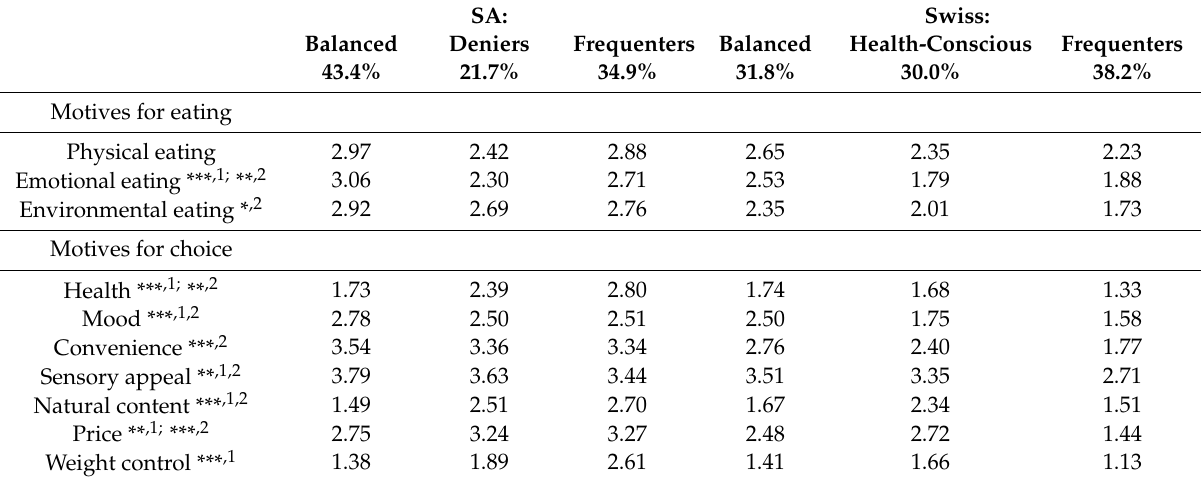
Table 4. Mean scores on the clustering scales and contrast analysis results by clusters of consumers’ motives for eating and choosing SBPs. SA: Swiss: Balanced Deniers Frequenters Balanced